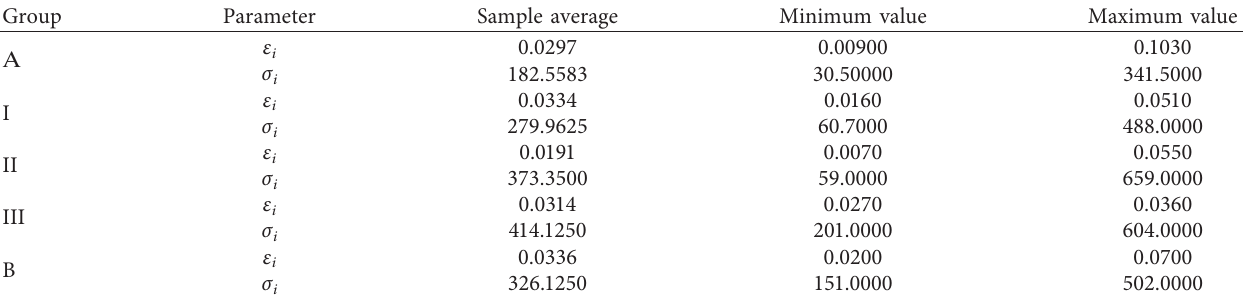
Figure 3: Experimental data on the change in the value of microplastic deformation ε in the deposited samples after heat treatment (according to Table 4) with increasing stress σ. Table 10: The results of experimental data statistical processing.